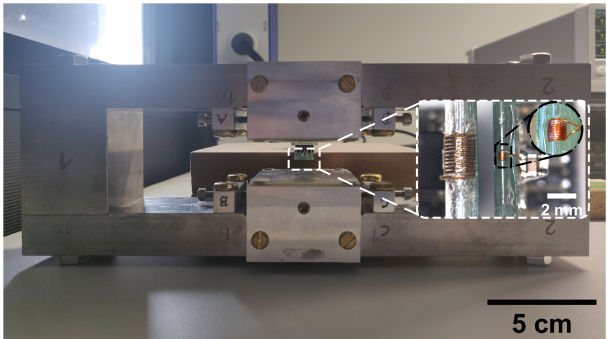
Figure 6. Photograph of the utilized 0.36T magnet with the two NMR coils as inset. Left: the relaxometry probe. Right: the spec- troscopy probe.